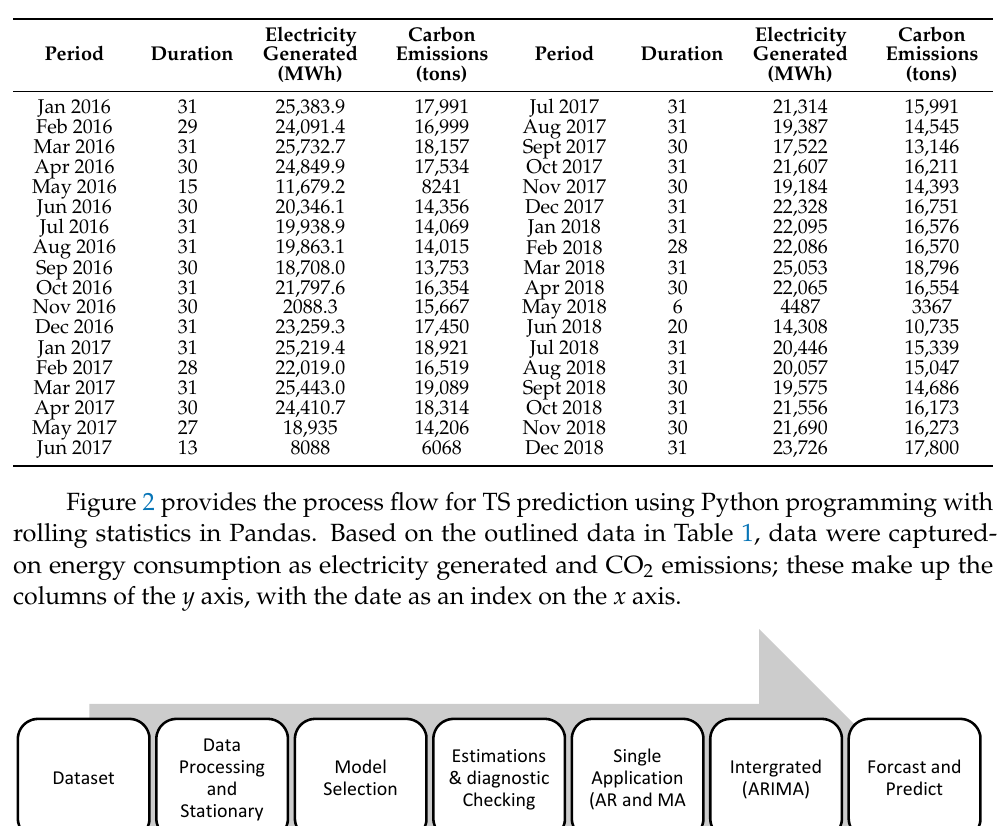
Table 1. Electricity generated and carbon emission data.